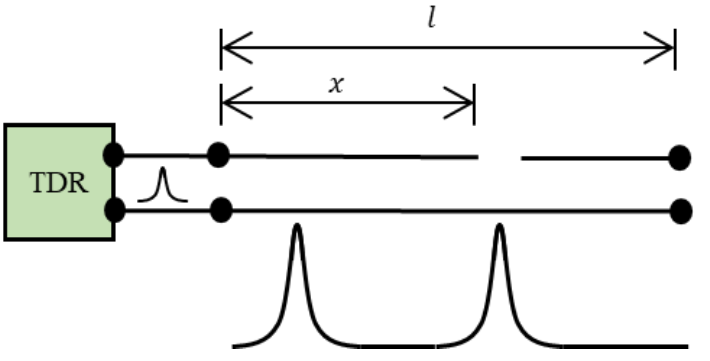
Figure 7. TDR fault